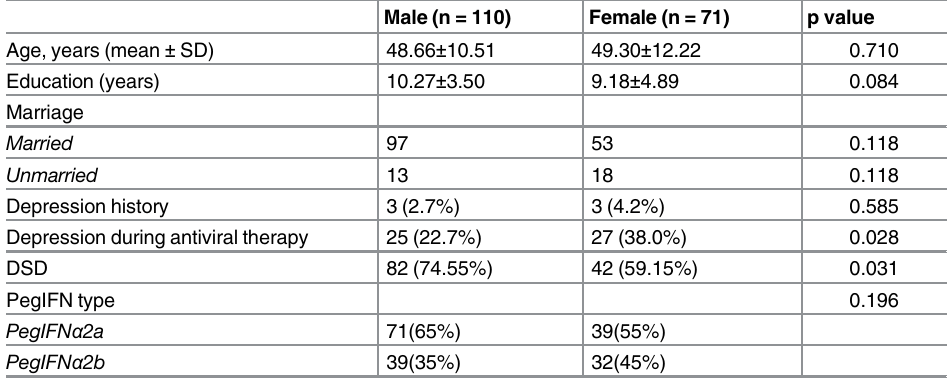
Table 3. Characteristics of the study patients, by sex.